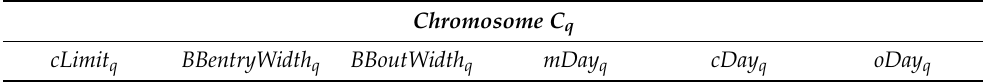
Table 1. Encoding scheme of chromosome C q